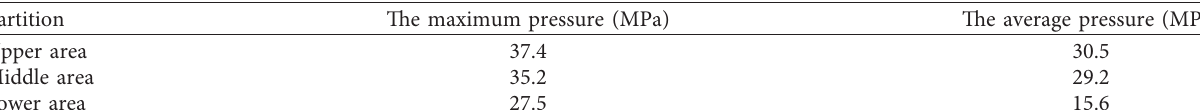
Figure 9: Working resistance monitoring curves of hydraulic support. (a) Working resistance monitoring curves of hydraulic support in the upper area. (b) Working resistance monitoring curves of hydraulic support in the middle area. (c) Working resistance monitoring curves of hydraulic support in the lower area. Table 1: Working resistance of hydraulic support in the 3307 working